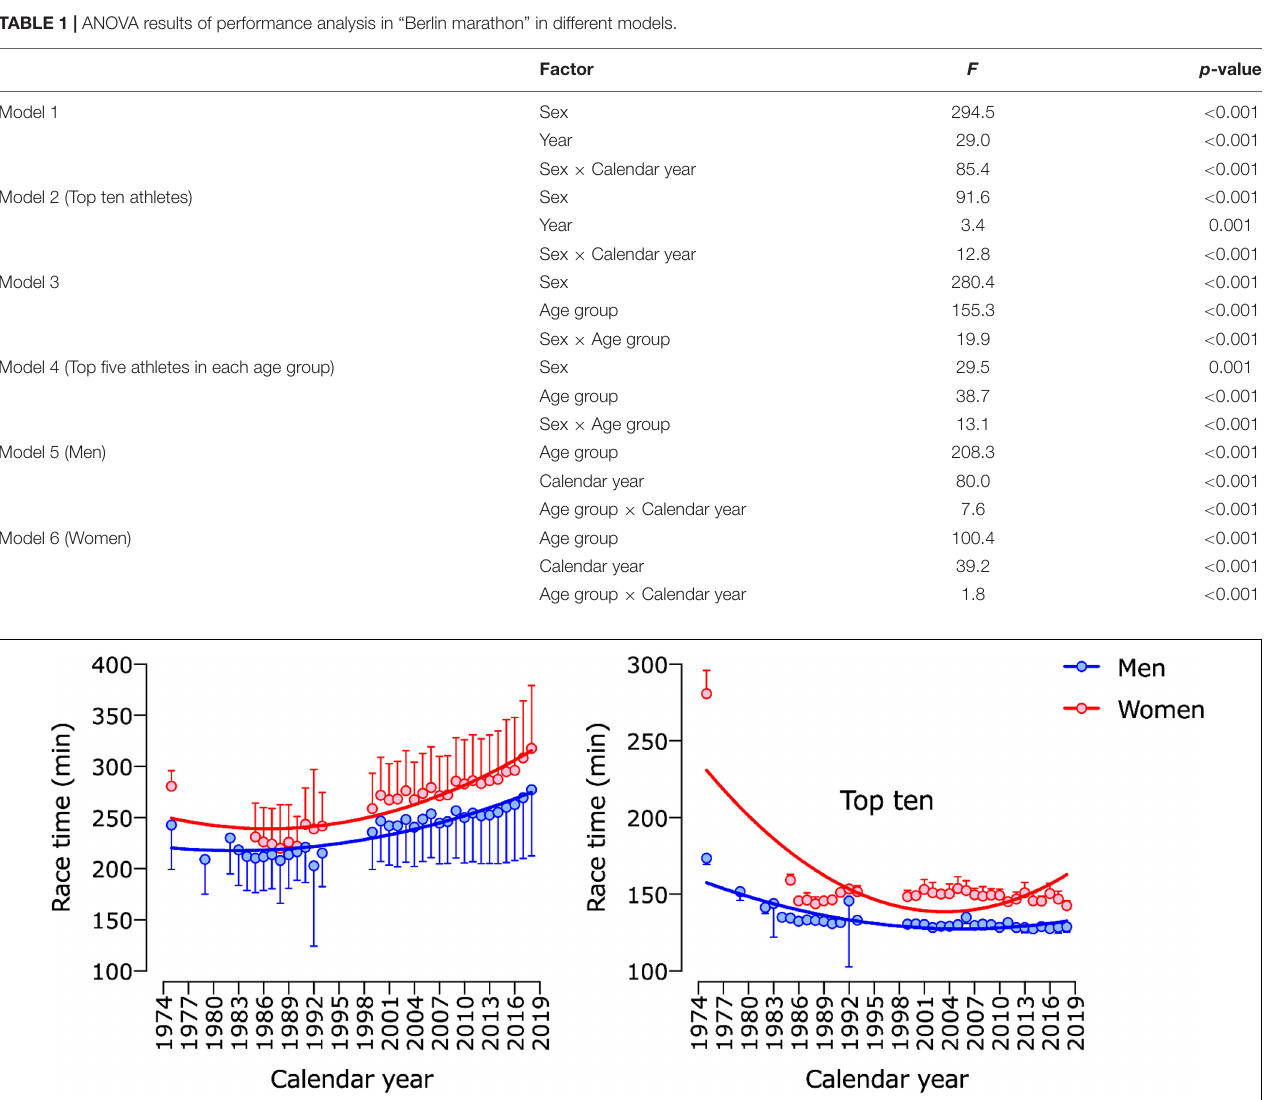
TABLE 1 | ANOVA results of performance analysis in “Berlin marathon” in different models.